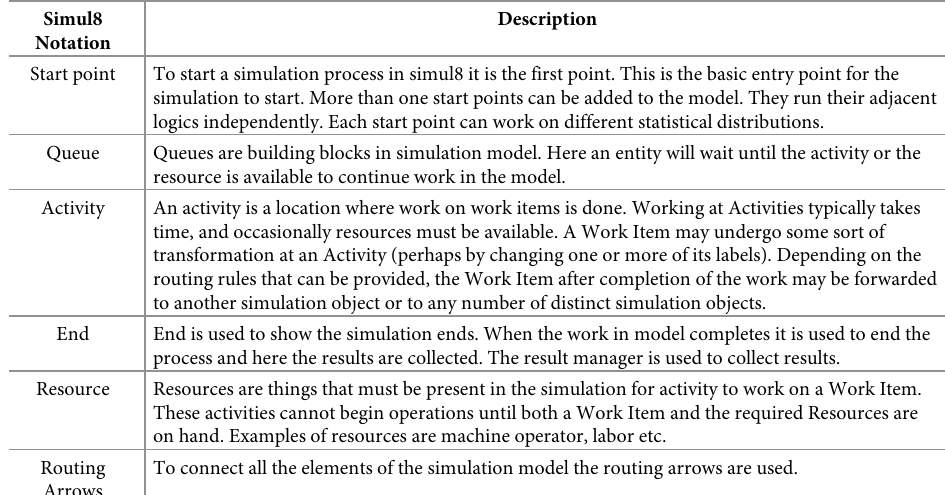
Table 4. Simul8 notation description.